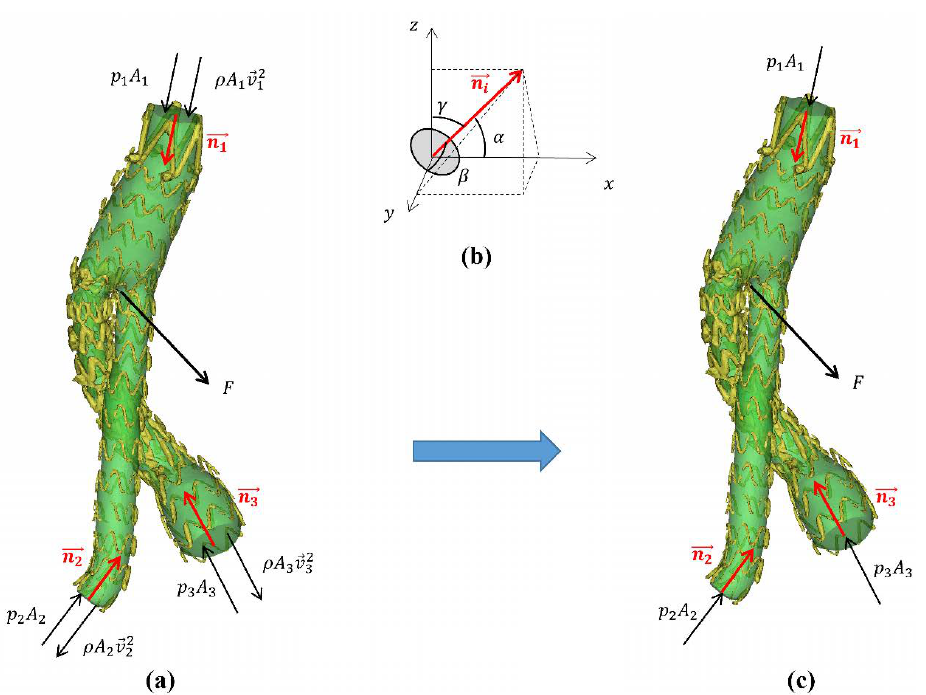
Figure 2. ( a ) Schematic diagram of each part of the momentum theorem formula. The red arrow indicates the direction of the unit normal vector; the black arrow indicates the direction of the represents momentum; represents the unit normal vector; force; represents the pressure; F represents the displacement force. ( b ) Schematic diagram of the unit normal vector. The normal 2 𝑛𝑛 𝚤𝚤 ���⃗ 𝑝𝑝 ρ A 𝑉𝑉�⃗ vector represents the direction of the plane and is defined as the cosine value of the angle between the positive direction of the coordinate axis and the vector. ( c ) Simplified stress diagram of a stent- graft; the displacement force is only related to the pressure, area, and angle of the inlet and outlet section. In this study, the direction of the unit normal vector was always perpendicular to the inlet and outlet section towards the SG. If we substitute the boundary condition of CFD into Equation (7), the ratio 𝑝𝑝 𝑖𝑖 𝑝𝑝 𝑖𝑖 / 𝜌𝜌𝑝𝑝 𝑖𝑖 𝑈𝑈 𝑖𝑖2 ranges from 76 to 16,396, indicating that the DF caused by the momentum change is negligibly small as compared to the pressure force. Therefore, Equation (7) can be simplified as follows: 𝐹𝐹⃗ = ( 𝑝𝑝 1 𝑝𝑝 1 ) 𝑛𝑛 1 ����⃗ + ( 𝑝𝑝 2 𝑝𝑝 2 ) 𝑛𝑛 2 ����⃗ + ( 𝑝𝑝 3 𝑝𝑝 3 ) 𝑛𝑛 3 ����⃗